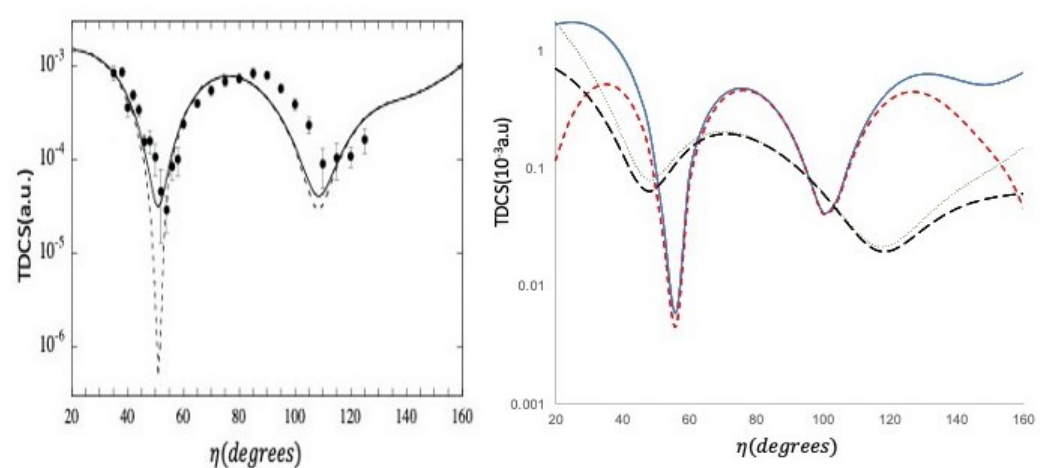
Figure 6. Left panel : TDCS for the electron impact ionization of Ne ( 2 s ) , E 0 = 110.5 eV, Φ = 42 ◦ , experimental points [33]; solid line DWBA calculation of [20], dashed line theory convoluted over the experimental angular uncertainty. Right panel : TDCS for the electron and positron impact ionization of Ne ( 2 s ) , E = 37 eV, Φ = 40 ◦ , electron impact DWBA (singlet exchange potential), solid blue, DWBA (singlet exchange potential)+ N e − e − short dashed red, positron impact: DWBA, long dashed black, DWBA+ N e + e − , green dotted.